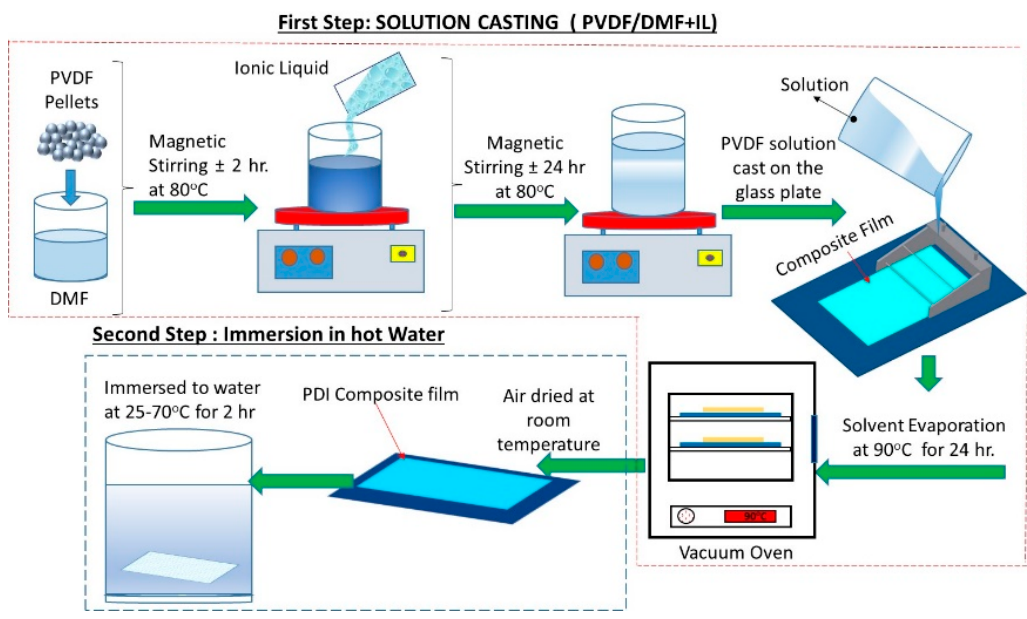
Figure 1. Schematic diagram of PVDF fabrication process.